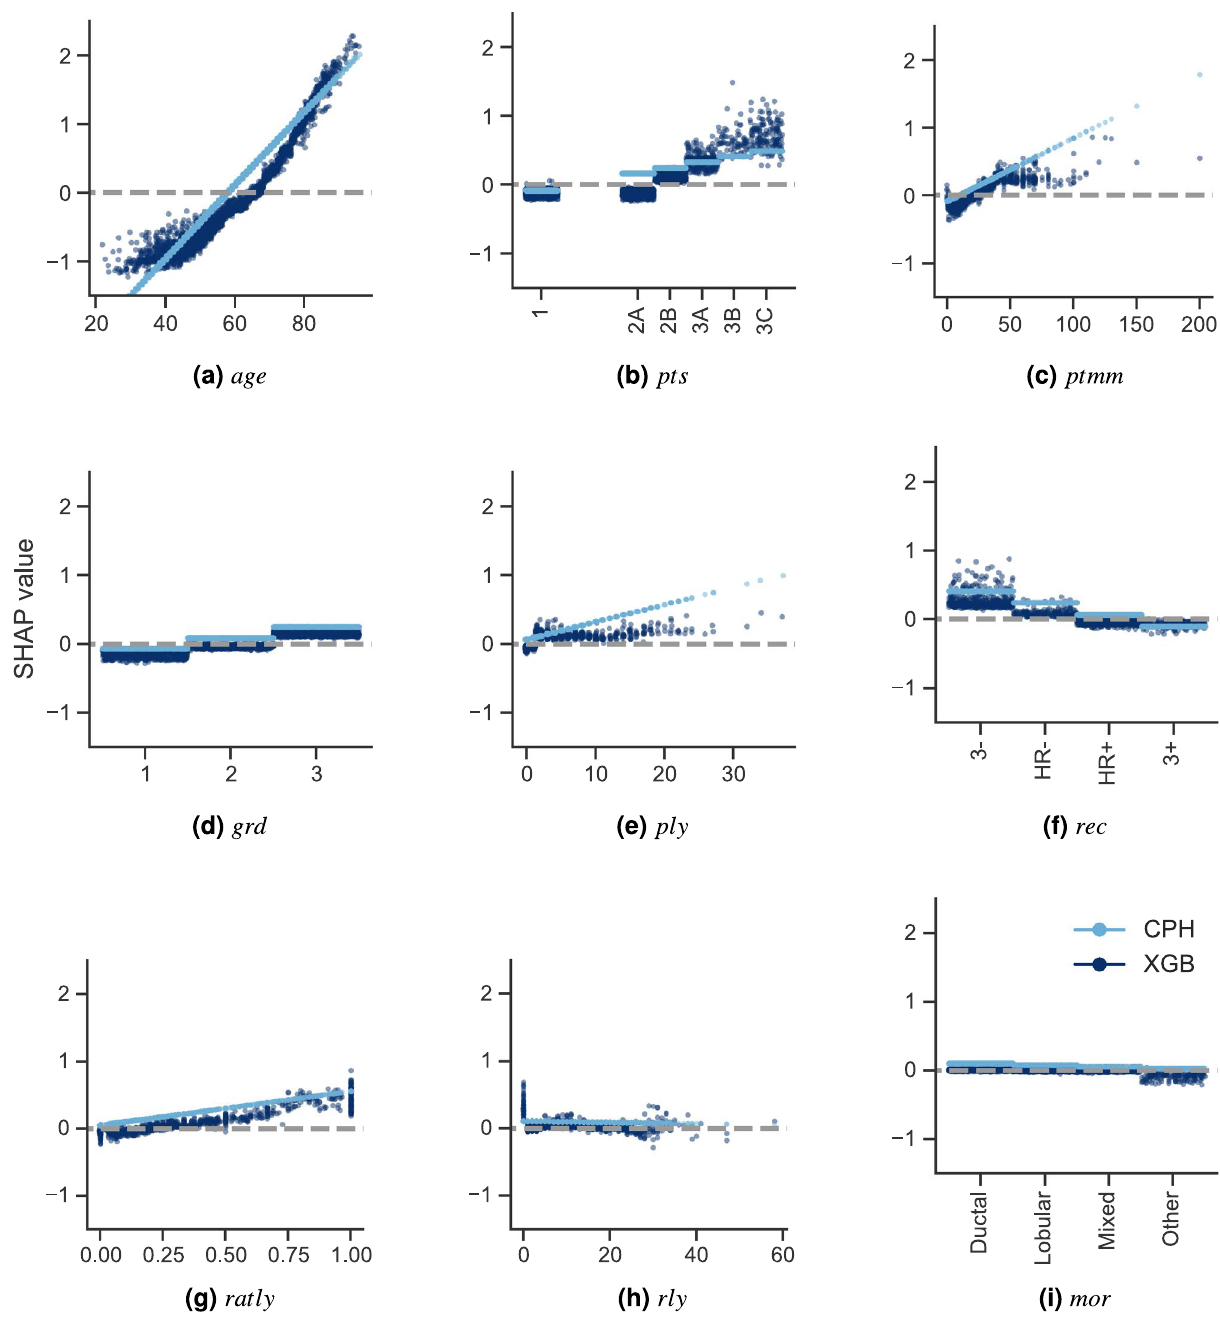
Figure 3. SHAP feature dependence plots. In the case of categorical variables, artificial jitter was added along the x axis to better show the density of the points. The scale of the y axis is the same for all plots in order to give a proper feeling of the magnitudes of the SHAP values for each feature (and therefore of their impact on the models’ output). In the case of the XGB model, the dispersion for each possible feature value along the y axis is due to interaction effects (which the CPH model is unable to